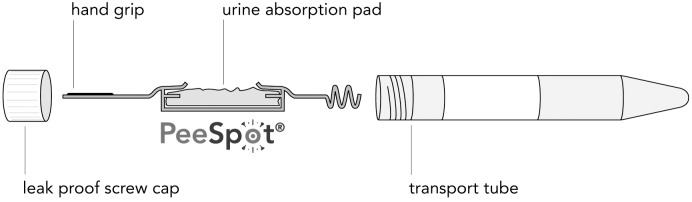
The PeeSpot system.